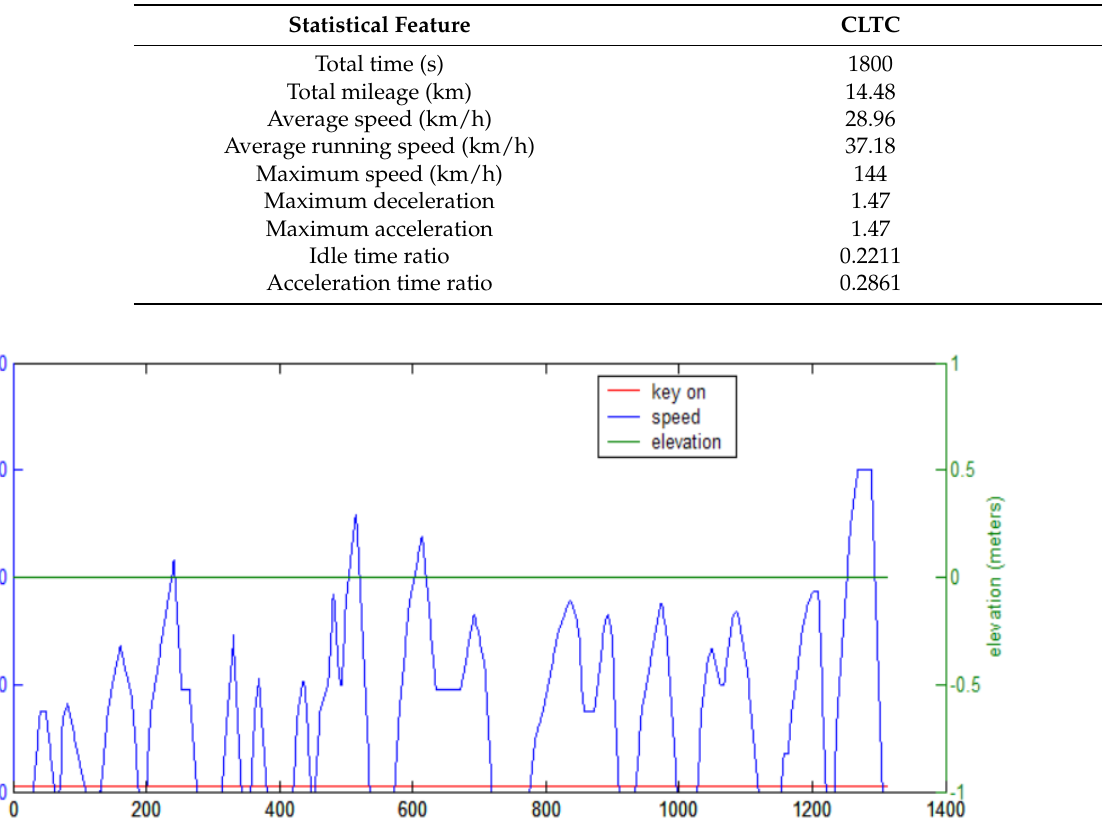
Table 7. Orthogonal parameter table.